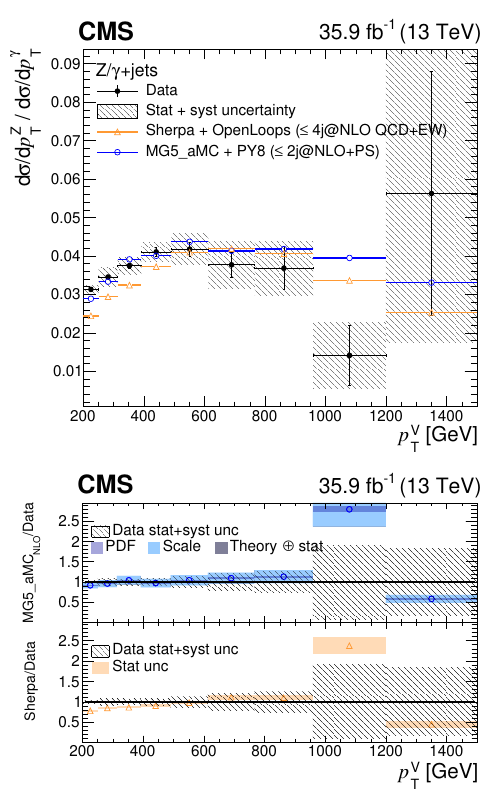
Figure 3 . Differential cross section ratio of Z + jets to γ + jets as a function of the vector boson (V) transverse momentum compared with the theoretical prediction from MadGraph 5_a mc@nlo and sherpa + OpenLoops . Only vector bosons produced centrally, with | y | < 1 . 4 , in association with one or more jets are considered. The lower panel shows the ratio of the theoretical prediction to the unfolded data. The vertical bars in the upper panel represent the statistical uncertainty in the measurement and the hatched band in the lower and upper panels is the sum in quadrature of the statistical and systematic uncertainty components in the measurement. The dark (light) shaded band on the NLO prediction from MadGraph 5_a mc@nlo represents the PDF (scale) uncertainties, which are treated as uncorrelated between Z+ jets and γ + jets, whereas the statistical uncertainties are barely visible. The shaded band on the sherpa + OpenLoops calculation is the statistical